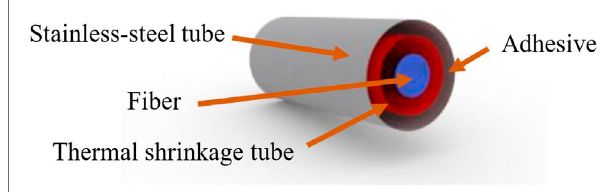
FIGURE 1 | FBG strain sensor with low temperature-sensitivity.